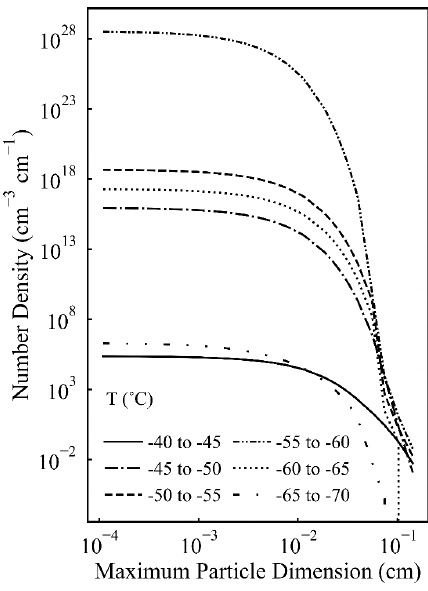
Figure 2. Variations in ice particle size distributions for different